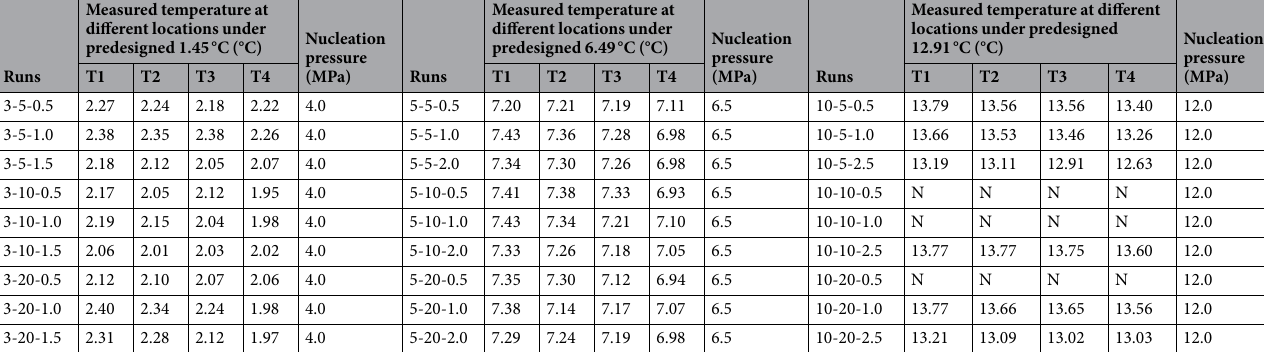
Table 1. Conditions of the initial hydrate nucleation at different locations. N means there was no hydrate nucleation at that location. These pressures are the measured values for the actual nucleation conditions. Some overpressure is required for triggering the hydrate nucleation, and the overpressures of 1.0, 1.5, and 2.0 MPa were measured in this study, corresponding to the designed pressure values of 3.0, 5.0, and 10.0 MPa, respectively.